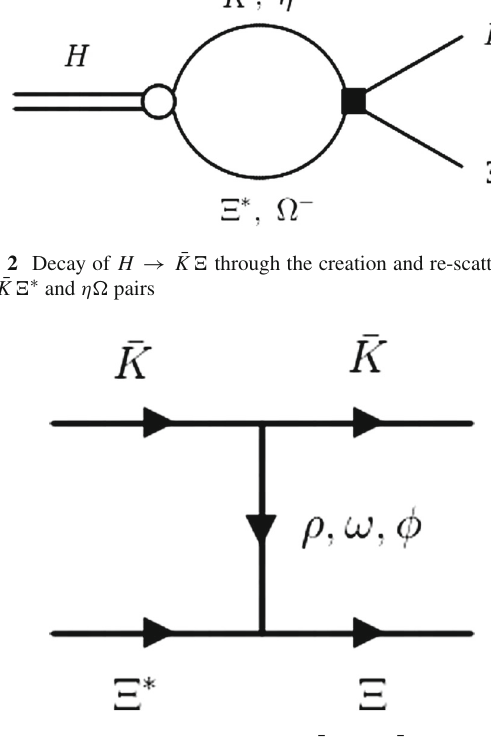
Fig. 3 Possible d-wave diagram for the ¯ K (cid:3) ∗ → ¯ K (cid:3) transition